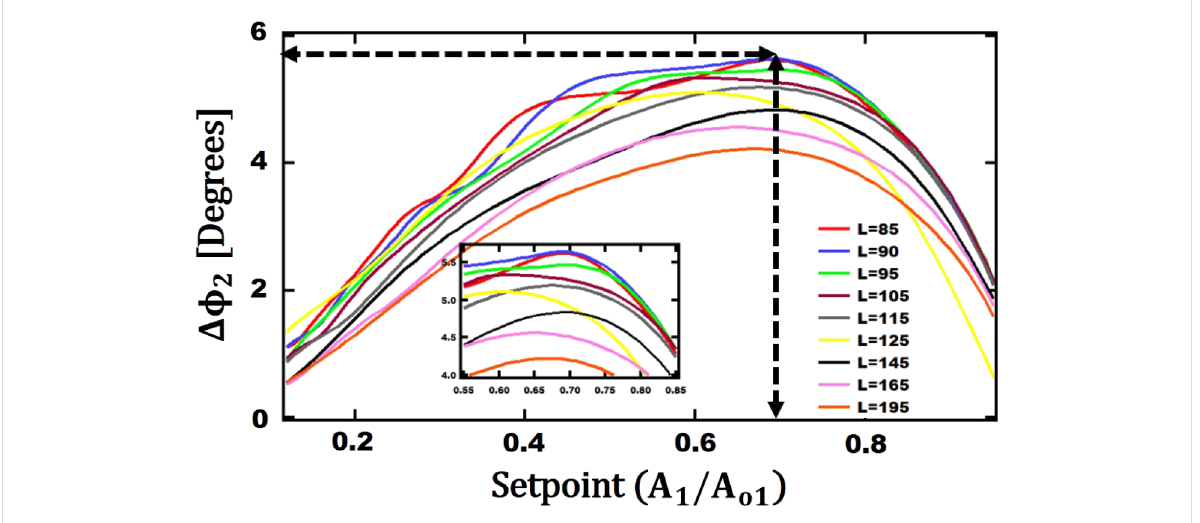
Figure 4: Second eigenmode phase difference between Au and PS versus setpoint for a given cantilever length. The other geometrical parameters are: